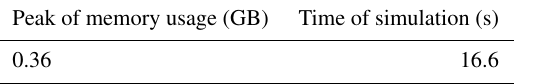
Table 2. Computational cost related to the execution of the forward solver when there is no employment of any ABCs methods. The velocity model was part of the Marmousi, with the settings shown in Table